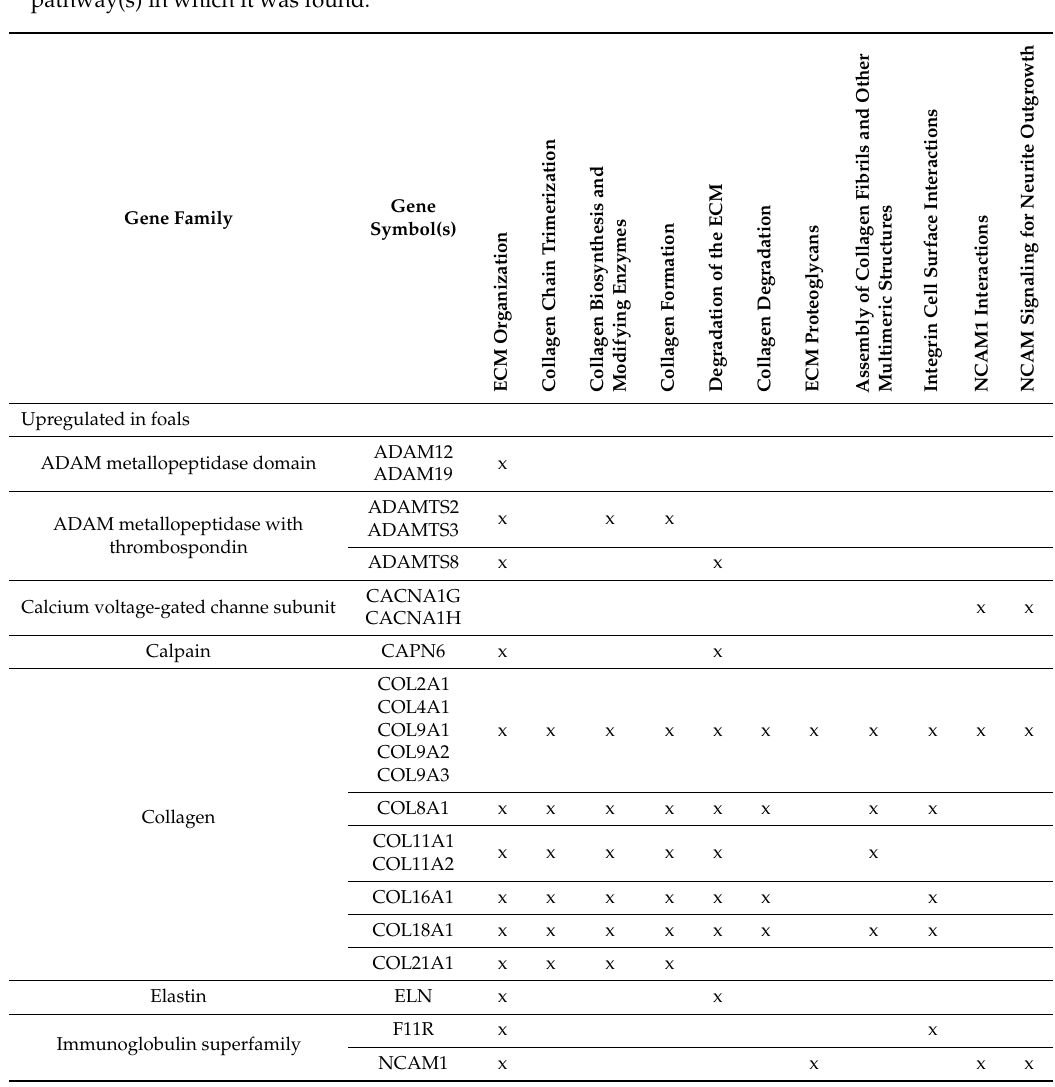
Table 4. Genes found within enriched pathways identified by both PANTHER and Reactome based on DE in articular cartilage. Only 3 out of 60 genes were found in a single pathway, while 8 genes (all collagen subtypes) were found in all enriched pathways. For each gene “x” designates the pathway(s) in which it was